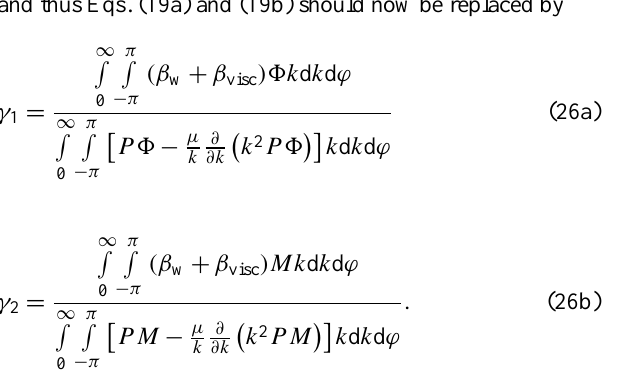
Fig. 2. Coefficient µ quantifying the downward spectral energy flux (as defined by Eq. 20), allowing balancing of the energy and mo- mentum budgets as a function of wind speed. The wave breaking term β br is from Komen et al. (1984), and the wind input term β w is from WAMDI (1988). The sea wave spectral model for k < 25 k p is from Elfouhaily et al. (1997), with directional spreading func- tion by Resio et al. (2011). Above k = 25 k p , the sea wave spectral model is either from Elfouhaily et al. (1997) (solid lines), or from Kudryavtsev et al. (2003) (dashed lines).